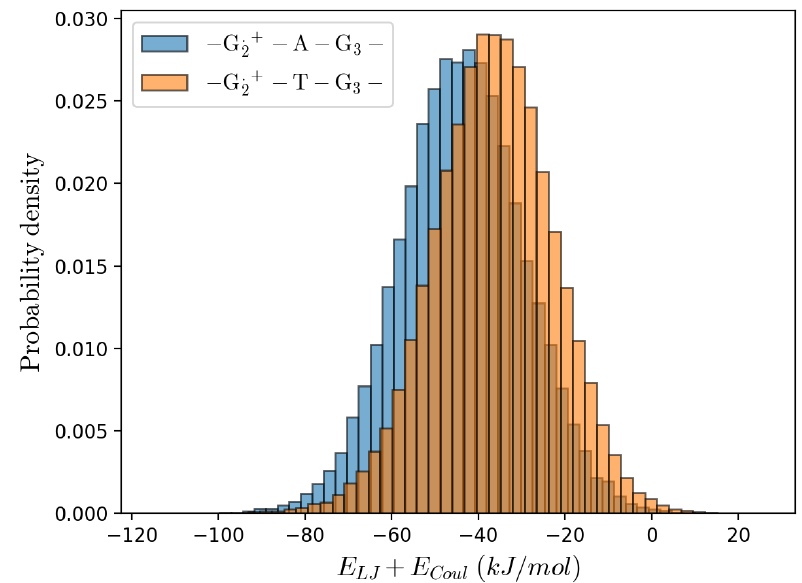
Figure 8. Solvent-G . + long range interaction energy 2